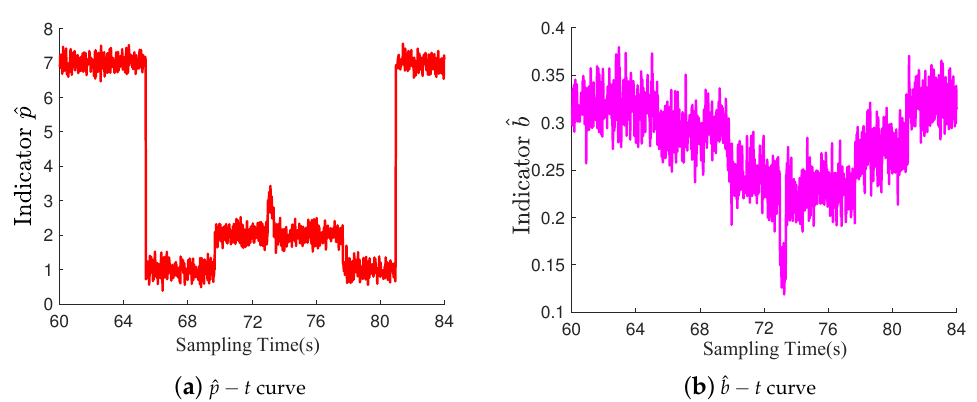
Figure 5. Indicators of the real 34-PMU power flow data around the occurrence of the multiple